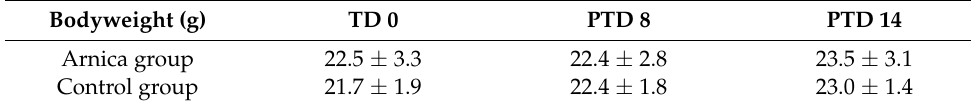
Table 3. Bodyweight development of the Arnica ( n = 6) and control ( n = 4) groups. Bodyweight